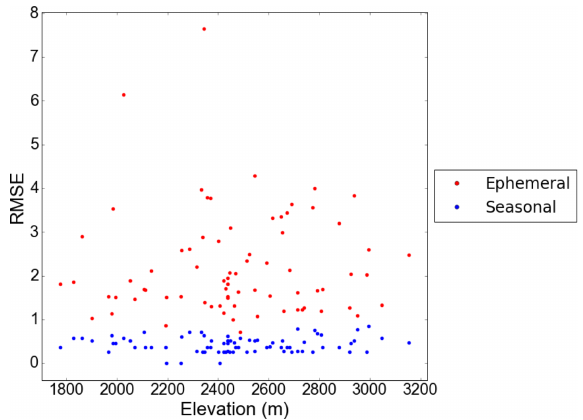
Figure A3. Root mean square errors between the number of ob- served ephemeral and seasonal snow events at Snow Telemetry (SNOTEL) stations and the number of ephemeral and seasonal snow events derived from the algorithm in Google Earth Engine in each 500m MODIS pixel corresponding to that station. Measured snow water equivalent of 0.3cm or greater was used to determine snow presence for SNOTEL sites.